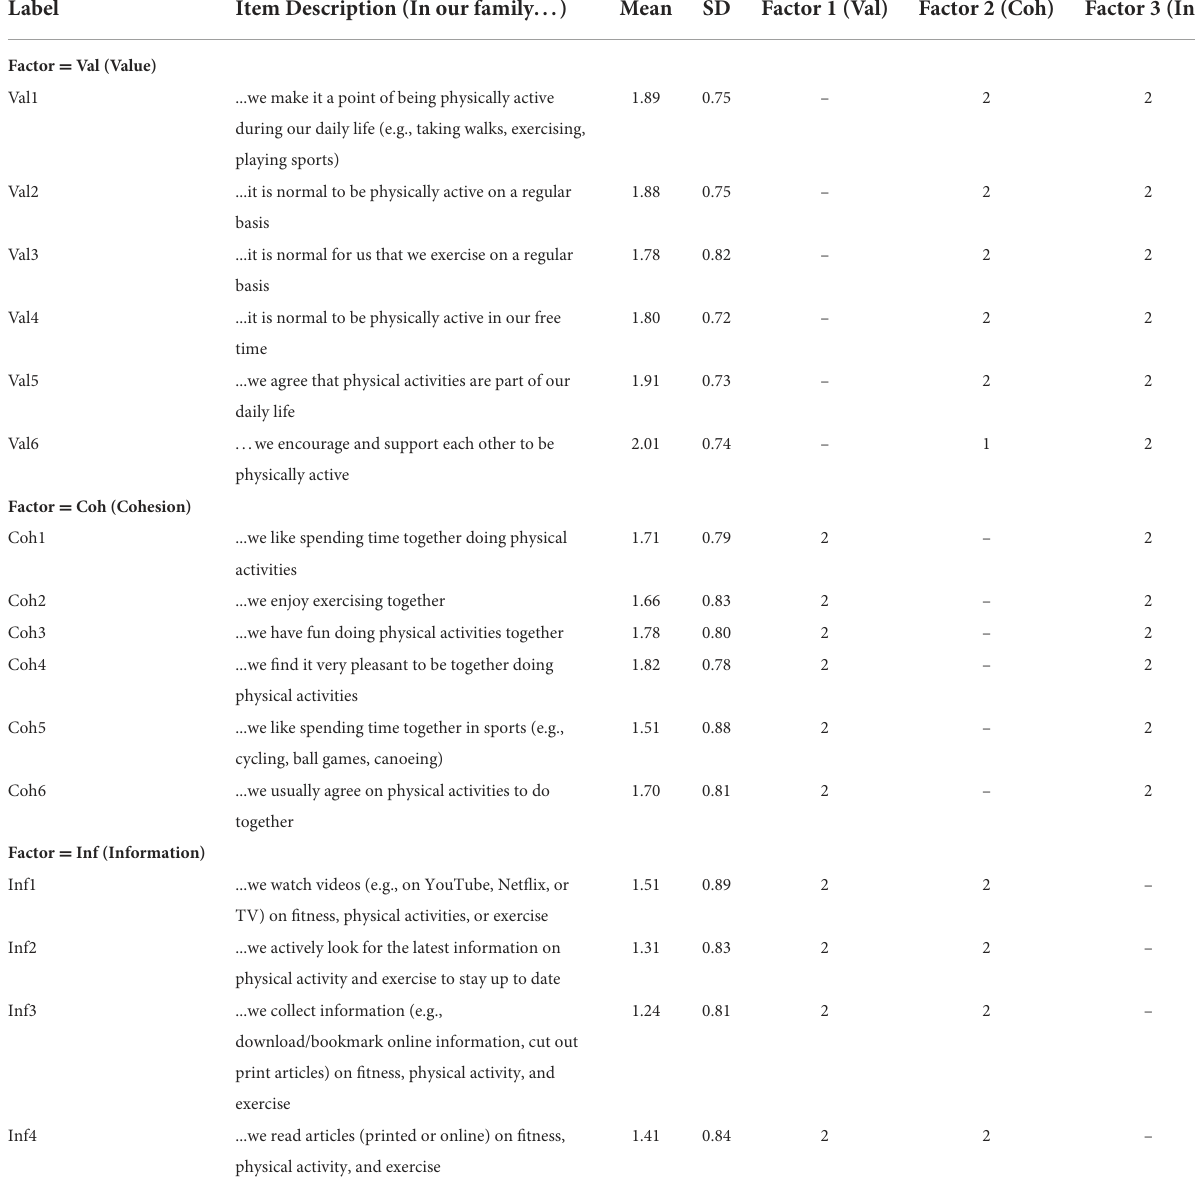
TABLE 6 Item-level discriminant validity testing for FHC-PA (Sg). FHC-PA (Sg) Label Item Description (In our family...) Mean SD Factor 1 (Val) Factor 2 (Coh)